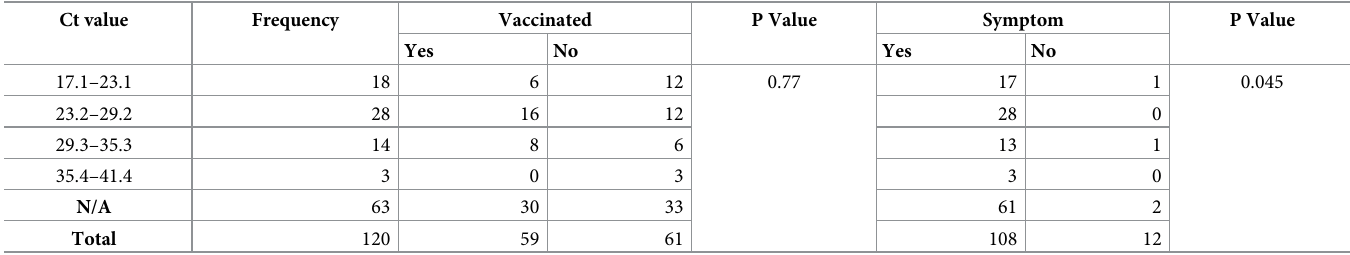
Table 4. Comparison of various groups of Ct values with vaccination status and symptoms of the participants. Ct